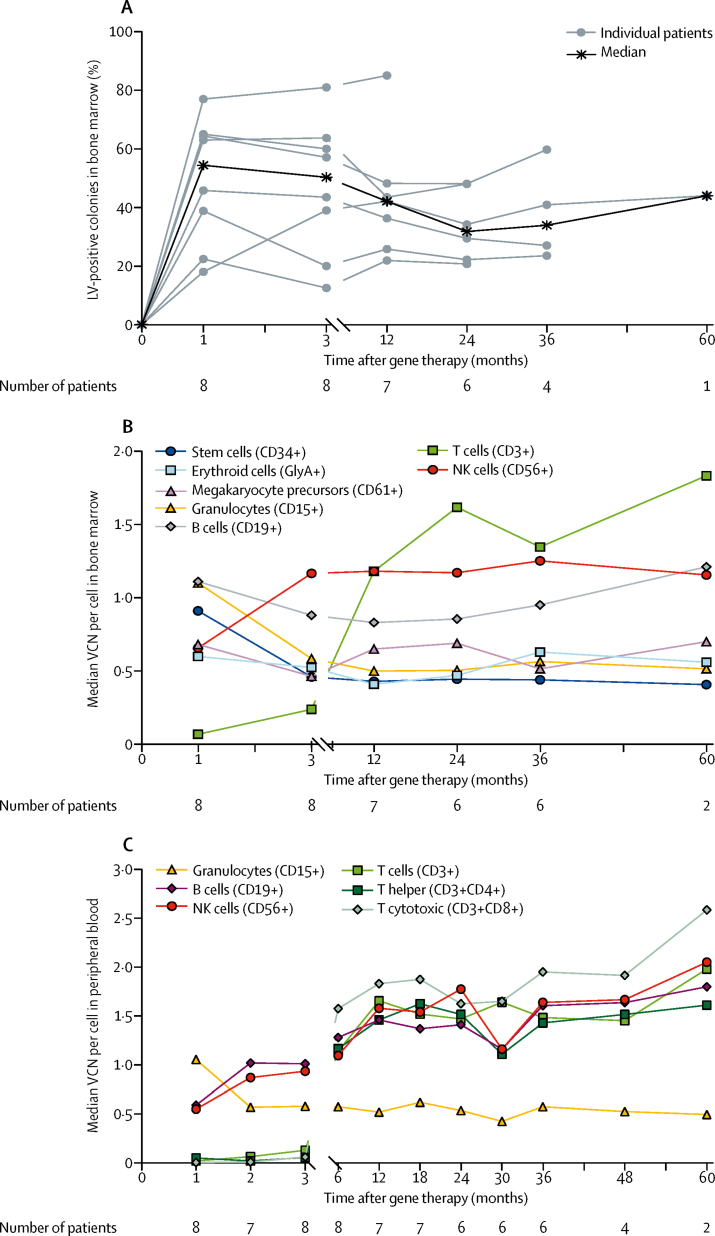
Multilineage engraftment of genetically corrected haemopoietic stem cells and peripheral blood cells in eight patients with Wiskott-Aldrich syndrome treated with lentiviral vector gene therapy(A) In-vivo engraftment of transduced progenitor cells in bone marrow (LV-positive colonies). (B) Median VCN per cell in bone marrow cell lineages. (C) Median VCN per cell in peripheral blood cell lineages. No vector was detected in bone marrow total cells analysed before gene therapy. LV=lentiviral vector. VCN=vector copy number. GlyA=glycophorin A. NK=natural killer.